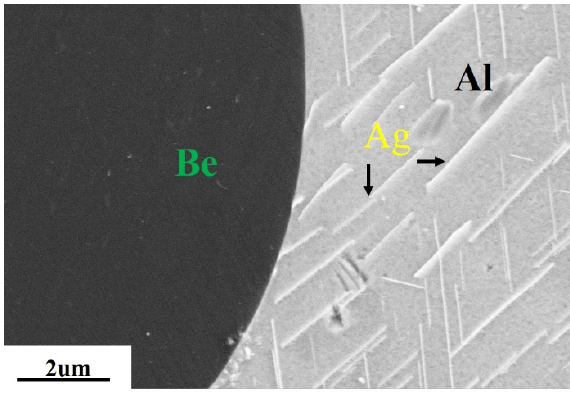
Figure 5. The SEM images of Ag precipitated phase.